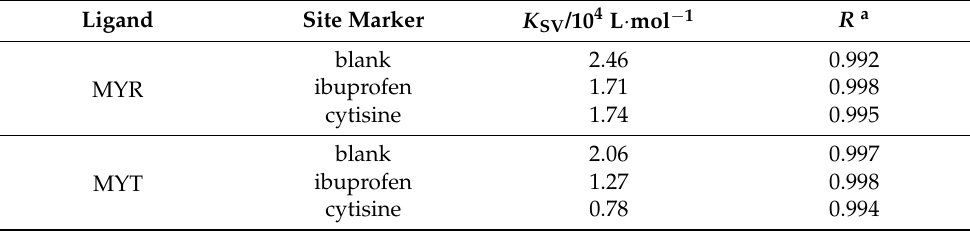
Table 4. The Stern – Volmer equation quenching constant ( K SV ) for the site-labeling competition ex- periments of PK-MYR and PK-MYT complexes.